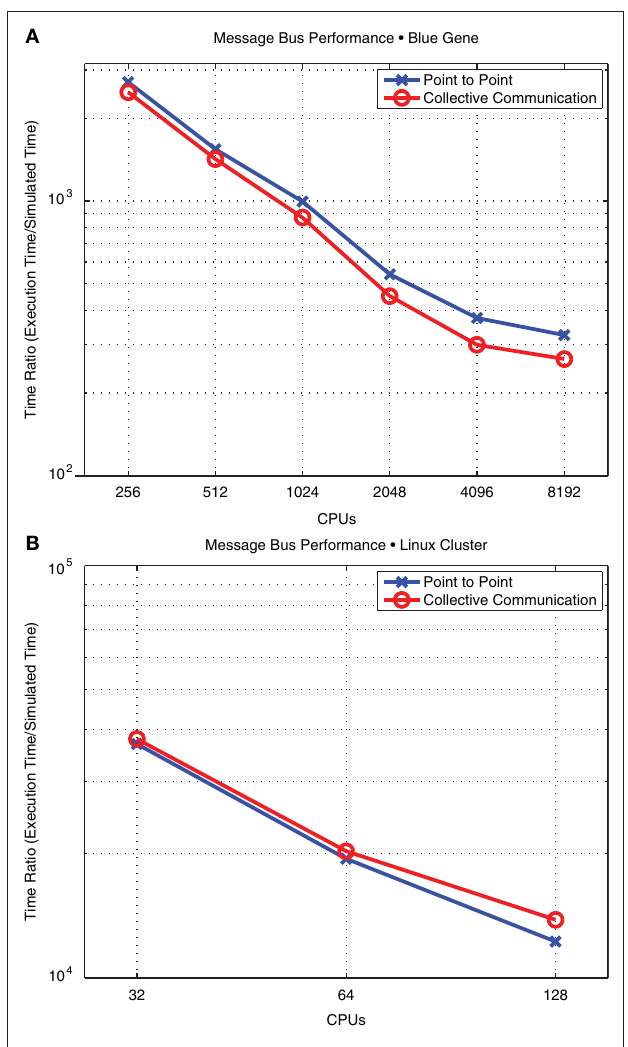
FIGURE 4 | Comparison of Message Bus performance. (A) Blue Gene collective calls (using MPI_AllGather) performance exceeds that of point-to- point (using MPI_Send and MPI_Recv) (B) on a Linux cluster, point-to-point version of the Message Bus achieves greater performance than collective